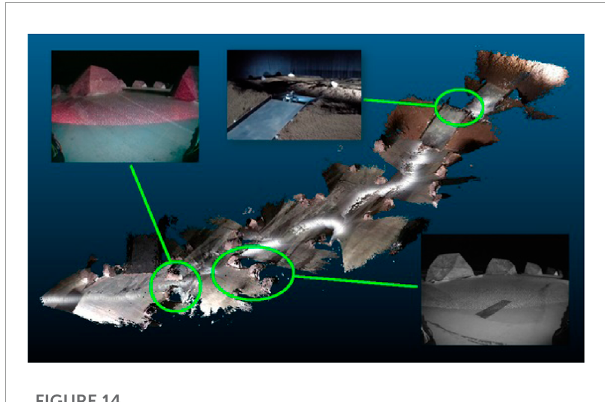
FIGURE 14 3D point cloud of the lunar environment of the challenge.